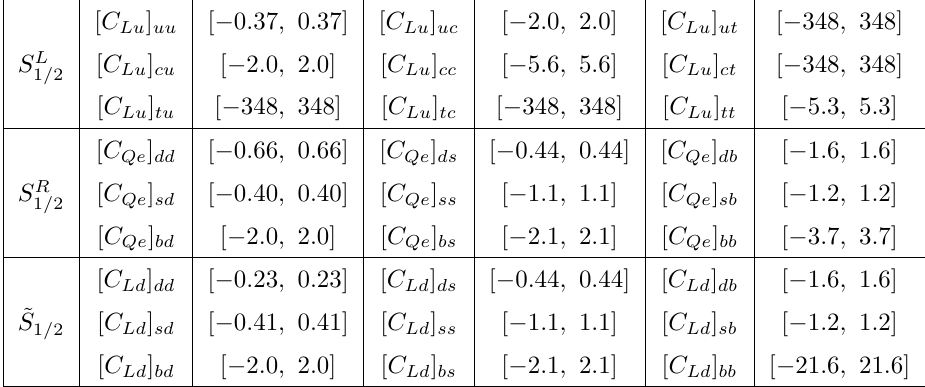
Table 18 . 90% C.L. ranges for the Wilson coefficients (in units of 10 − 3 ), in the three leptoquark models considered here. The ranges are obtained after marginalizing over all other